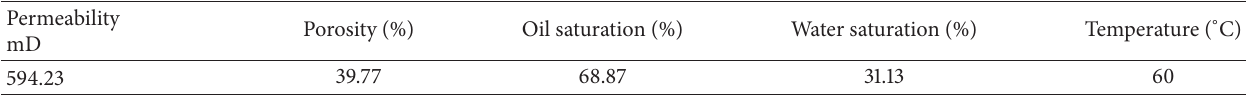
Table 2: Sand pack filling conditions and